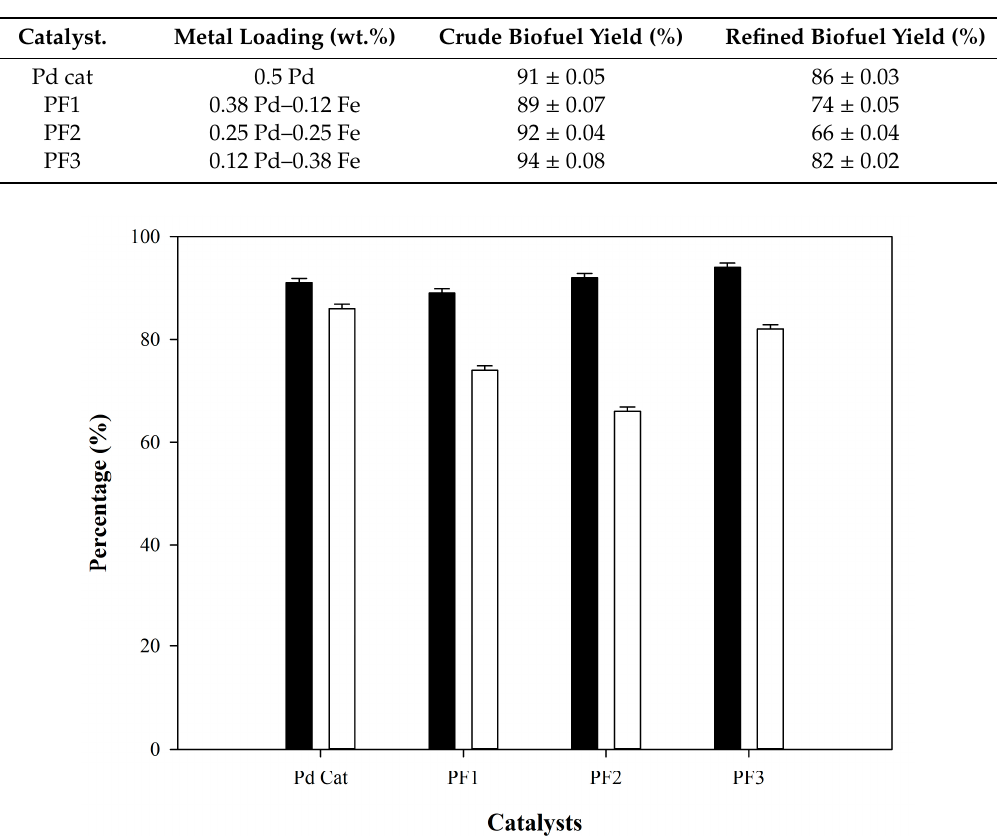
Table 3. Crude biofuel yield and valuable product obtained from catalytic hydrocracking reaction of monometallic and bimetallic catalysts.